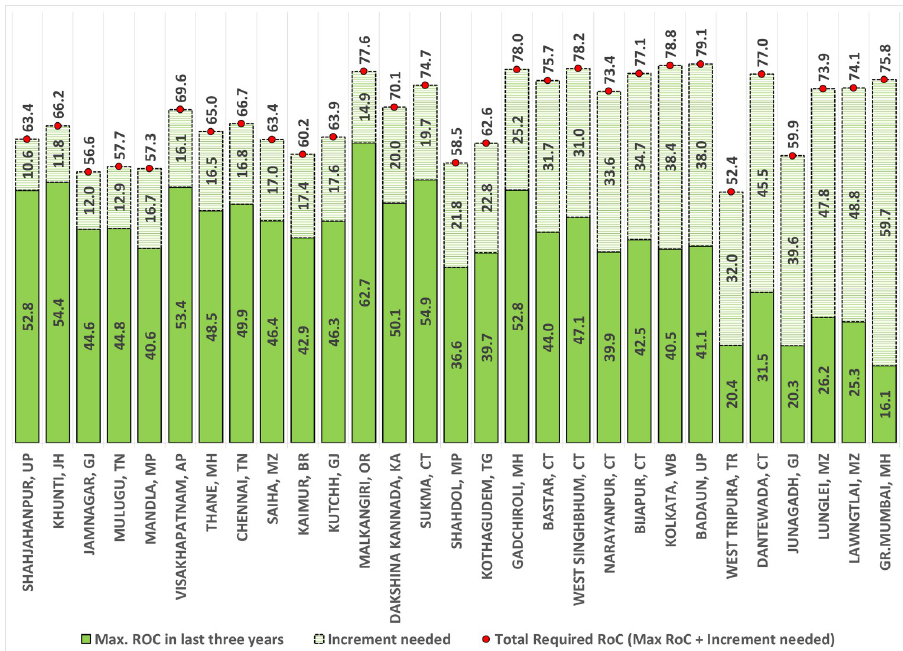
Fig 4. Maximum AROC in the last three years, amount of increment needed in AROC and required AROC in the cohort of 15 most vulnerable districts of India that would reach zero case status after 2030 if necessary interventions are not deployed on